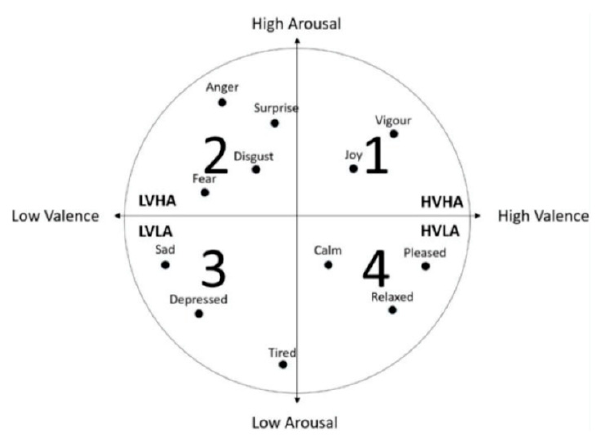
Figure 2. The Arousal-Valence model.